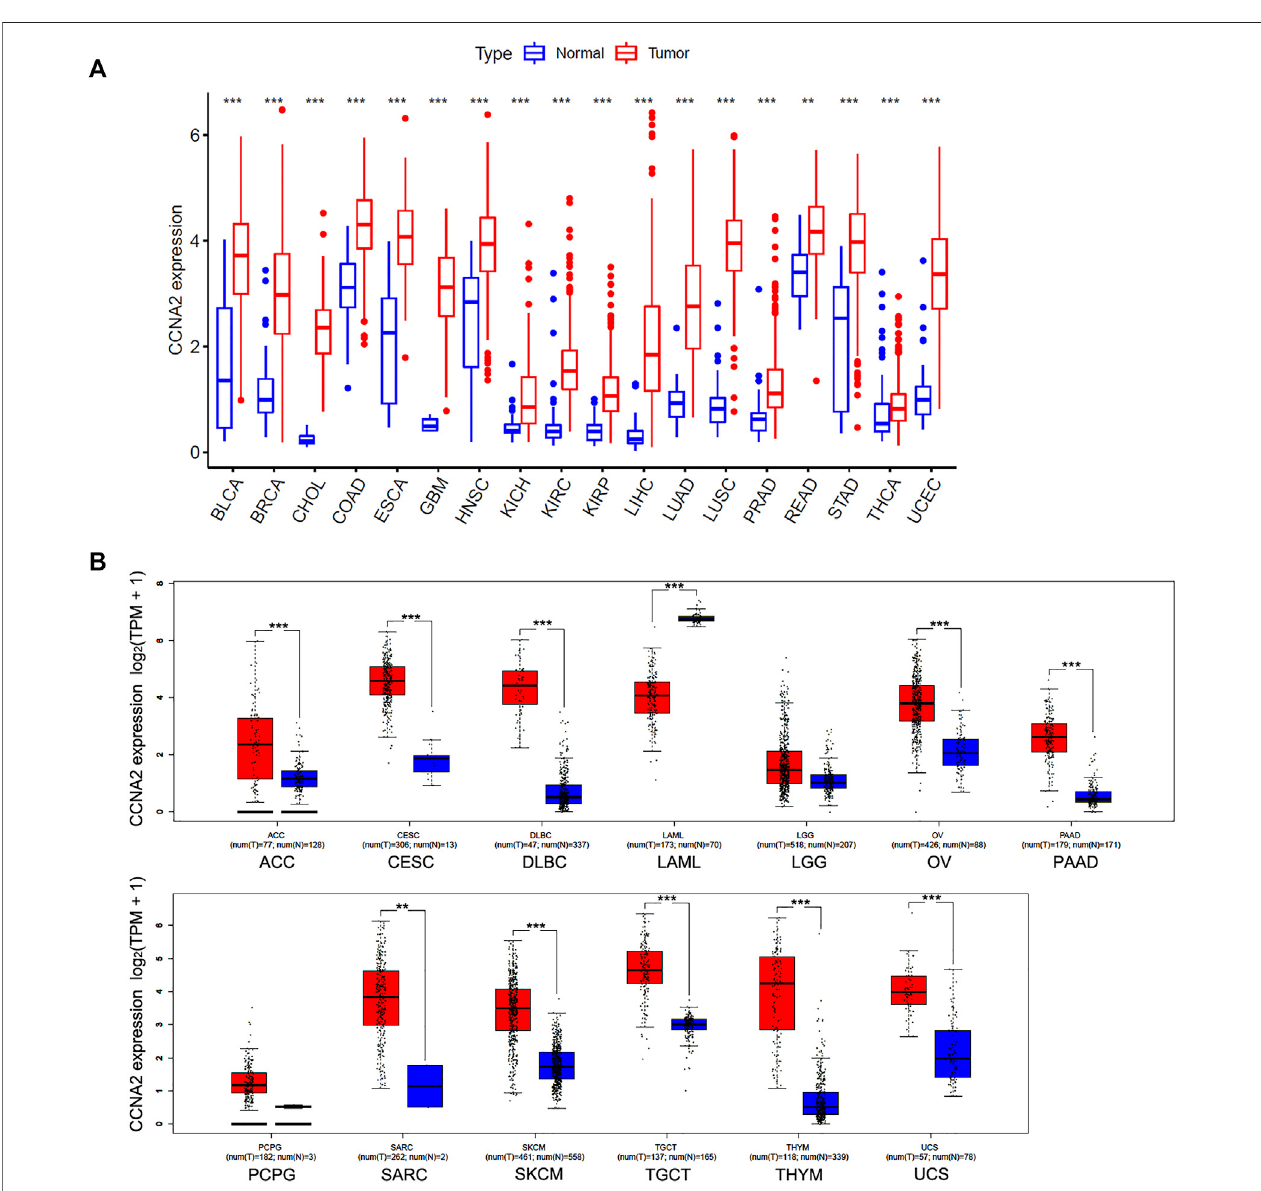
FIGURE1| ExpressionAnalysisofCCNA2invariouscancers. (A) TheexpressionoftheCCNA2in18cancertypeswith fi veormorenormaltissuesfromtheTCGA project via R language. (B) The expression of the CCNA2 in 13 other cancer types, normal tissues from GTEx project, or TCGA + GTEx as controls. ** p < 0.01, *** p <